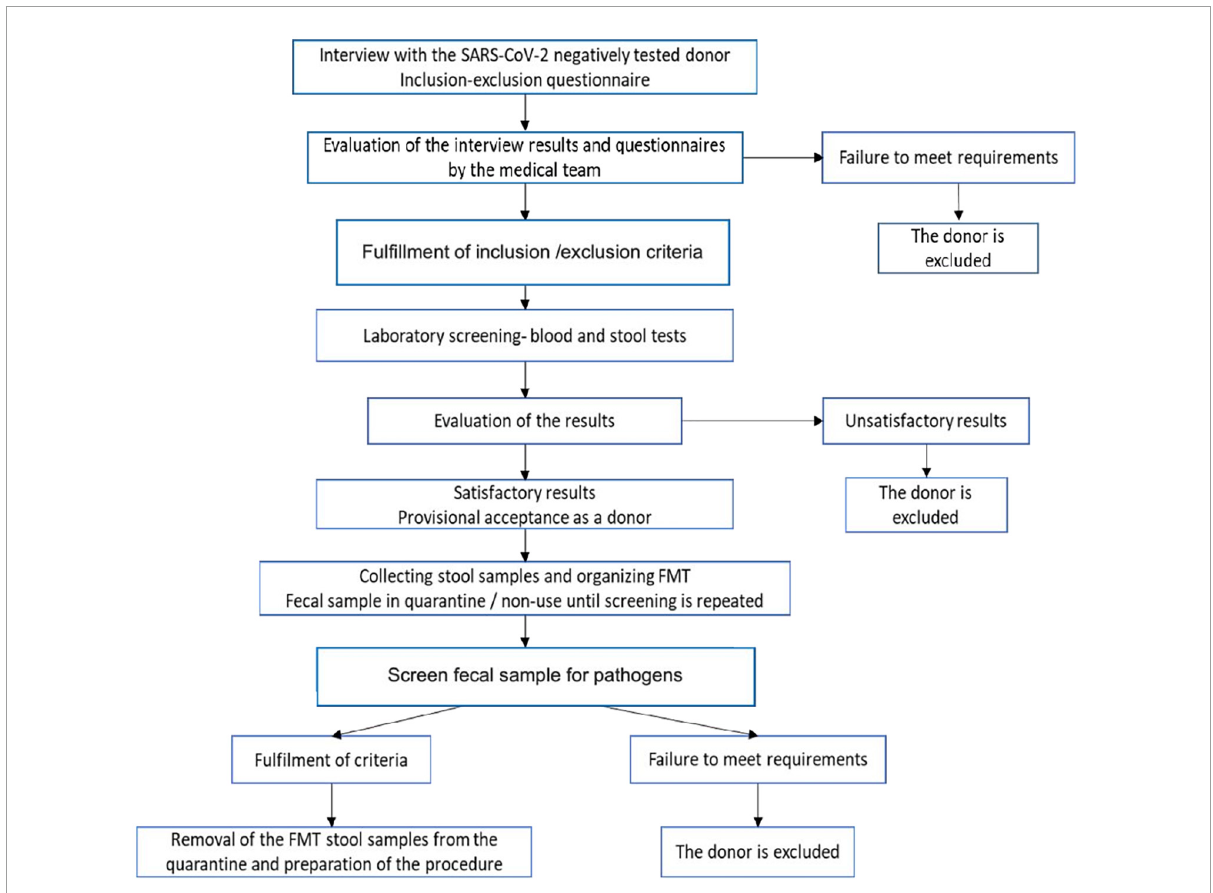
FIGURE2 Donor selection and sample preparation flow chart. Patient first undergo screening for SARS-CoV-2, then are assessed with the inclusion-exclusion questionnaire. Donors excluded if the criteria are not met. If inclusion/exclusion criteria met, donors will undergo laboratory blood and stool testing for antibodies/antigens. Donors excluded if they test positive for any antigens/antibodies that can be transmitted through FMT. If blood and stool testing negative, fecal samples will be collected and stored for use in –80 ◦ C Celsius freezers. Prior to administration, fecal samples should be checked again for pathogens to ensure safety. If final screening criteria fulfilled, fecal sample is removed from isolation and prepared for the